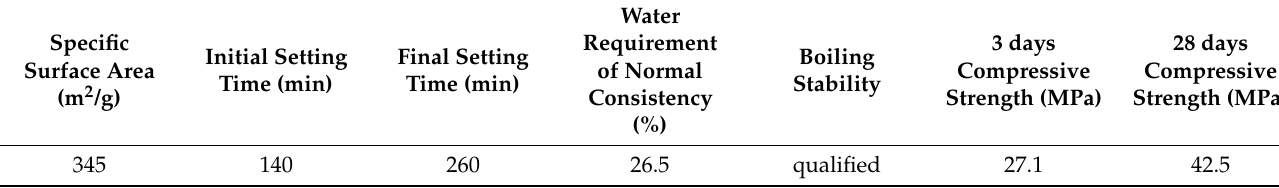
Table 1. Physical properties of